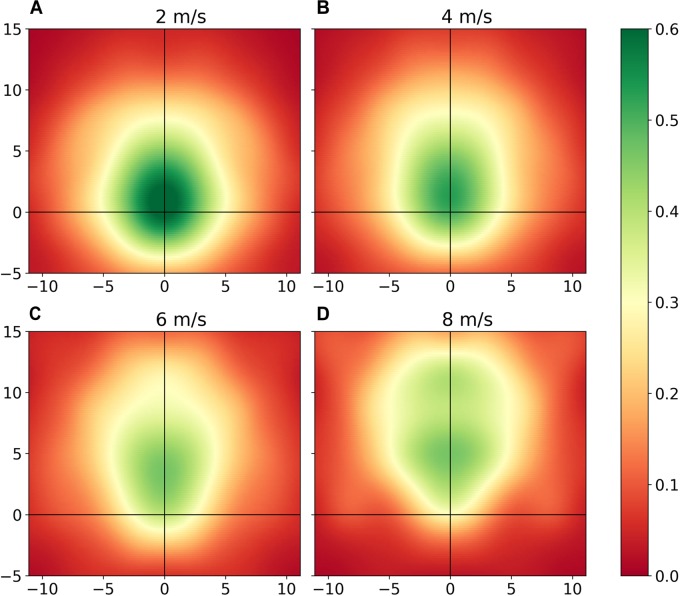
Motion models representing a player’s area of influence when moving at (A) 2 m/s, (B) 4 m/s, (C) 6 m/s, and (D) 8 m/s for ball time-to-point of 2 s. Heatmap intensity is equivalent to the probability that a player (at the point of origin) would participate in a contest at relative x-, y-co-ordinates, as quantified by observed commitment behaviors.